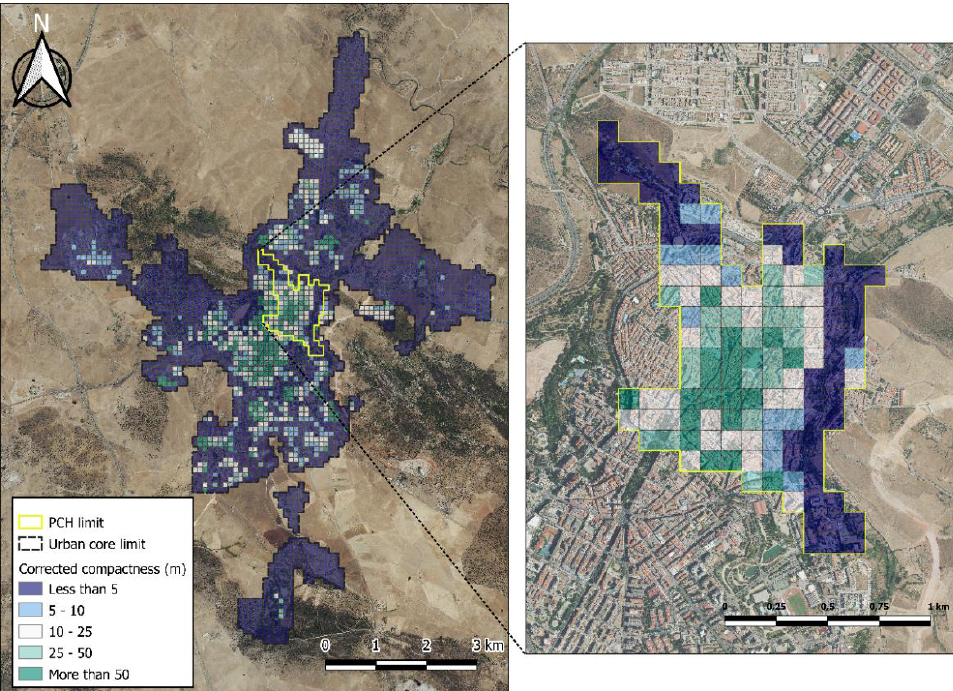
Figure 5. Corrected compactness comparison.